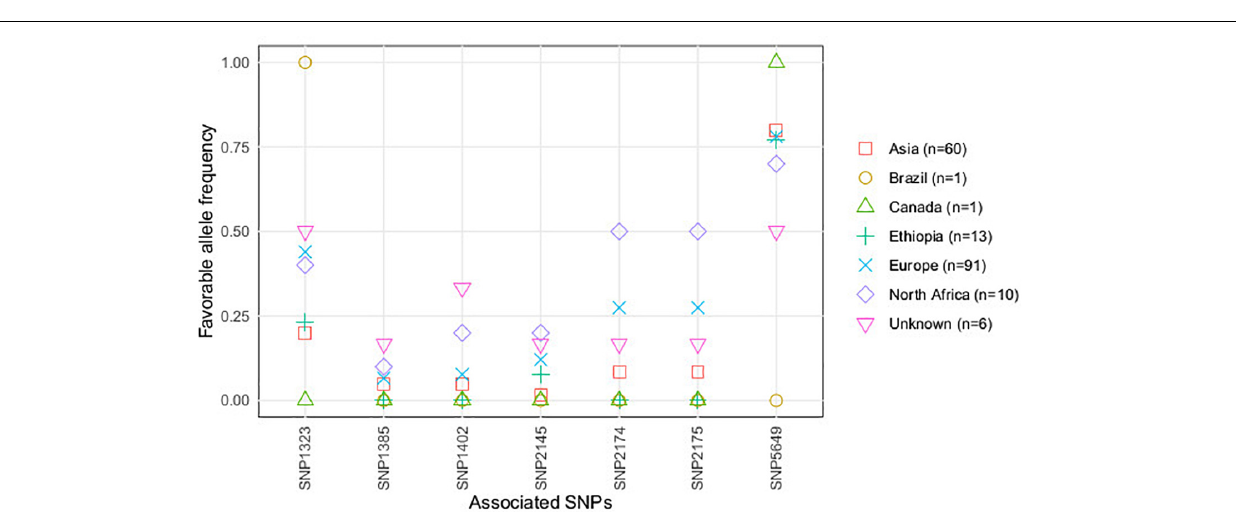
FIGURE 3 | Favorable alleles’ frequency (conferring resistance) of the SNPs associated with U. pisi DS, based on the grass pea accessions classified by seed size (large, small) and seed color (light,